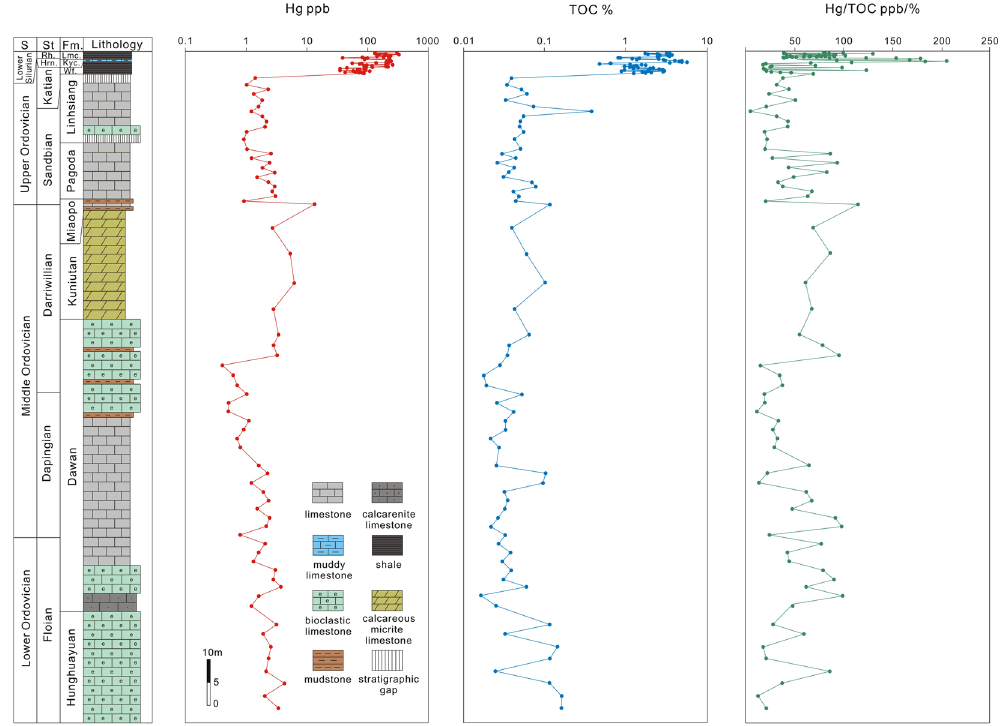
Figure 2. Geochemical plots of trends in Hg, TOC (total organic carbon) and Hg/TOC for Yichang sections through Ordovician and Lower Silurian. Yichang sections include Huanghuachang, Chenjiahe and Wangjiawan. Abbreviation: S = Series, St = Stage, Fm. = Formation, Wf. = Wufeng, Kyc. = Kuanyinchiao, Lmc = Lungmachi, Hrn. = Hirnantian, Rh. =